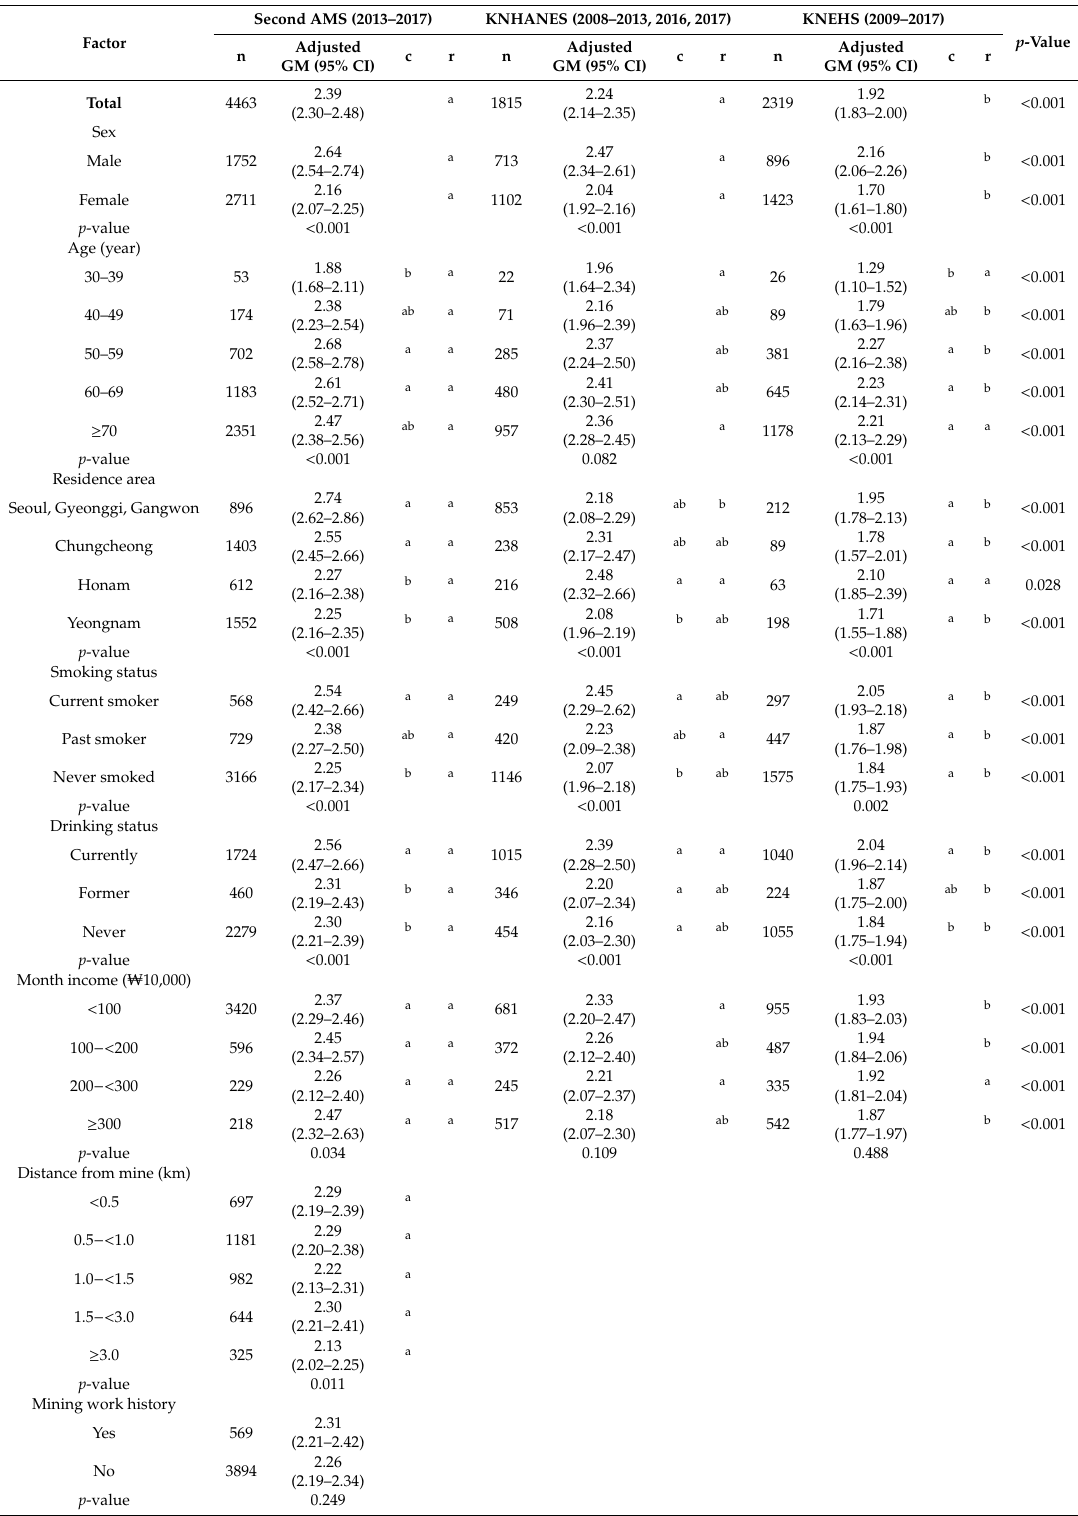
Table 2. Adjusted geometric means of the blood lead (Pb) concentration ( µ g /